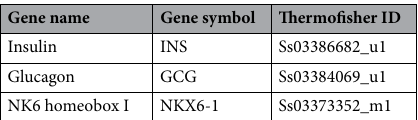
Table 7. Validated porcine primer and probe